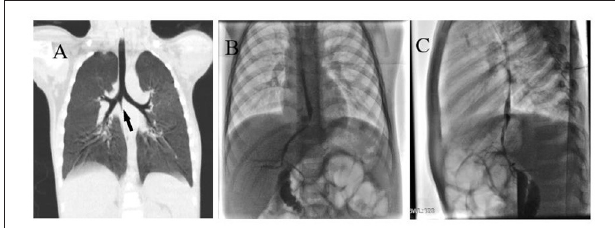
FIGURE 1 | (A) Right main bronchus wall with conical cleft-like protrusion (black arrow). (B) Anteroposterior angiography of BBF. (C) Lateral angiography of